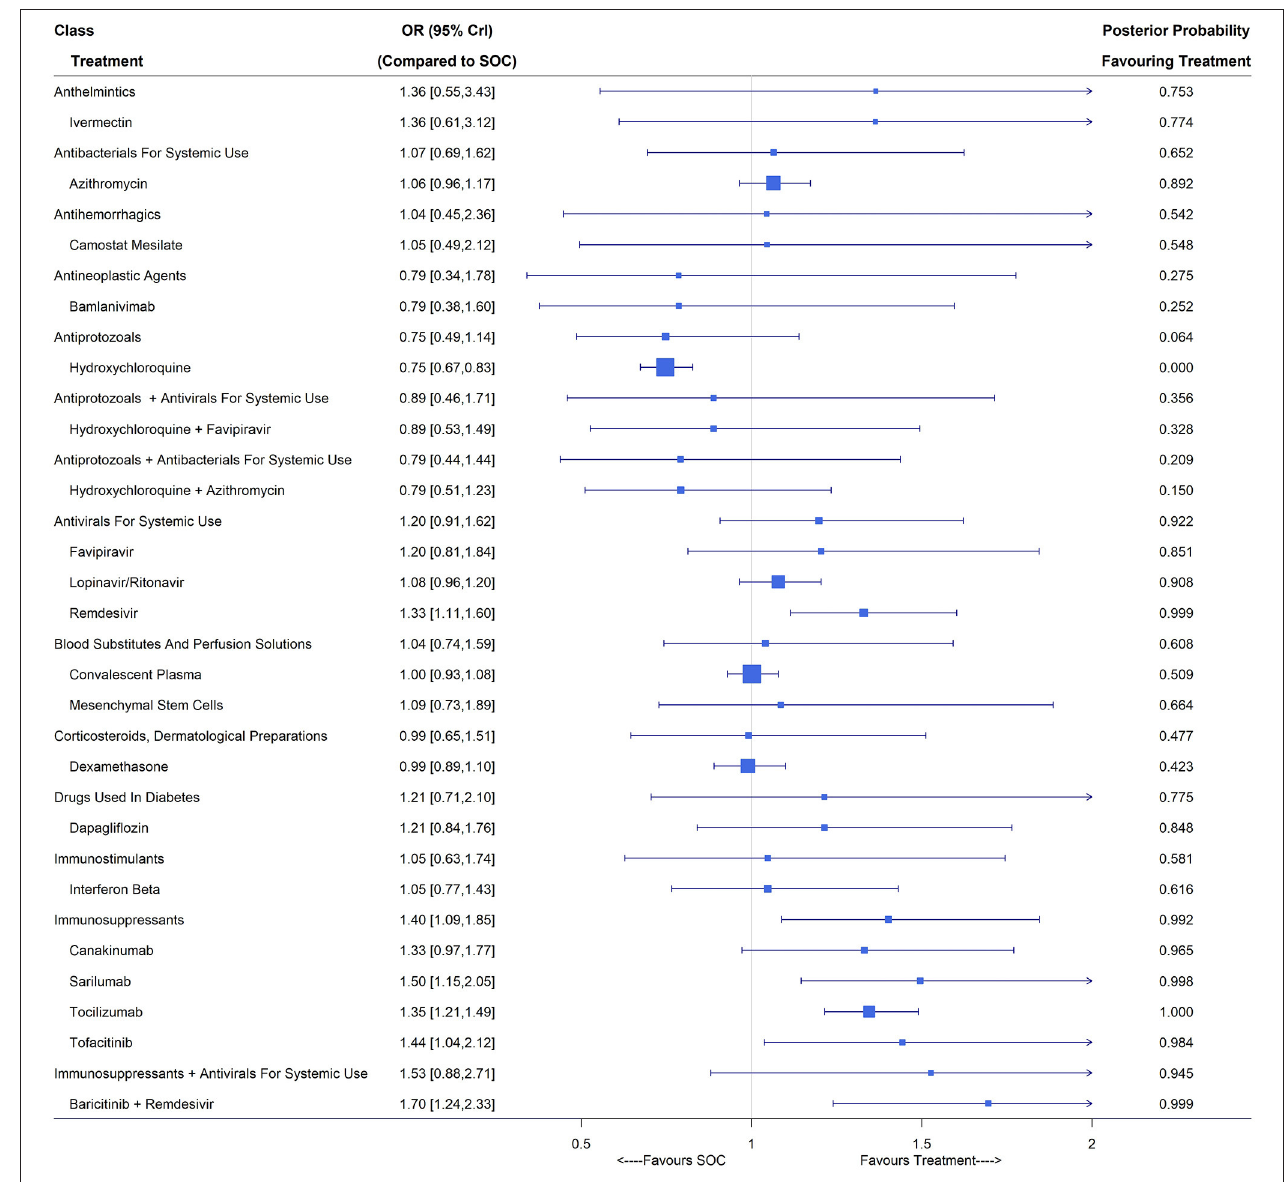
FIGURE 4 | Discharge (closest to 14 days) under treatments compared with the standard of care (SOC); OR is the odds ratio and CrI represents the credible interval.